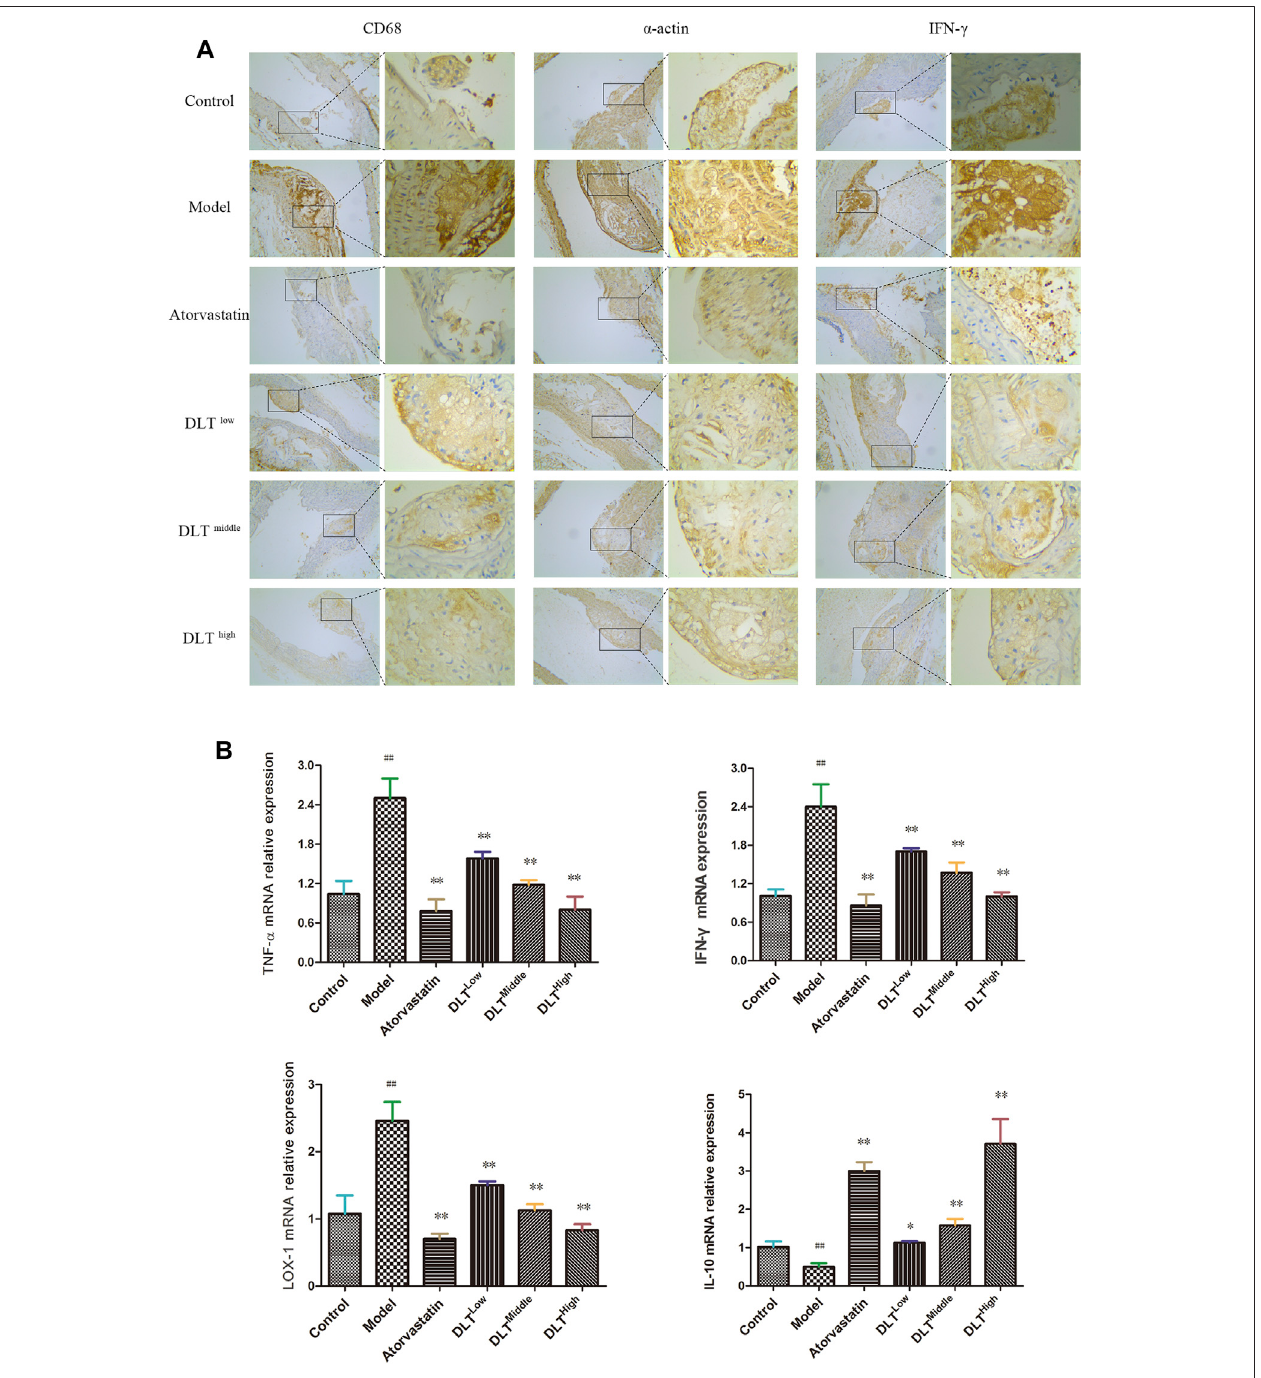
FIGURE 3 | Changes in macrophage (CD68) in fi ltration and the expression of LOX-1, the in fl ammatory factors TNF- α , IFN- γ , IL-10 and smooth muscle ( α -actin) in the aorta of ApoE - / - mice. Macrophage (CD68) in fi ltration, the in fl ammatory molecule IFN- γ and smooth muscle ( α -actin) were evaluated by immunohistochemical staining (A) , and the mRNA expression levels of LOX-1, TNF- α , IFN- γ and IL-10 were analyzed by RT-PCR (B). (A) CD68, α -actin, and IFN- γ immunohistochemical staining showed brown-yellow granules atherosclerotic lesions of the aorta in each group. Among all groups, the brown-yellow granules in the model group were themostabundantandweredecreasedgraduallyinadose-dependentmannerintheDLTgroups;theatorvastatingroupalsoexhibitedfeweryellowgranulescompared with the model group. (B) mRNA levels of the proin fl ammatory factors IFN- γ and TNF- α and oxidized low-density lipoprotein receptor LOX-1in the model group were signi fi cantlyhigher thanthoseinthecontrolgroup. TheatorvastatingroupandtheDLTgroupstreatedwithlow,middle,and highdosesexhibitedreducedexpressionof IFN- γ , TNF- α and LOX-1 mRNA. The mRNA expression of the anti-in fl ammatory factor IL-10 was signi fi cantly increased in the atorvastatin group and DLT groups. The data are presented as the mean ± SEM ( n (cid:2) 7). ## p < 0.01 vs the control group, and * p < 0.05, ** p < 0.01 vs the model group.